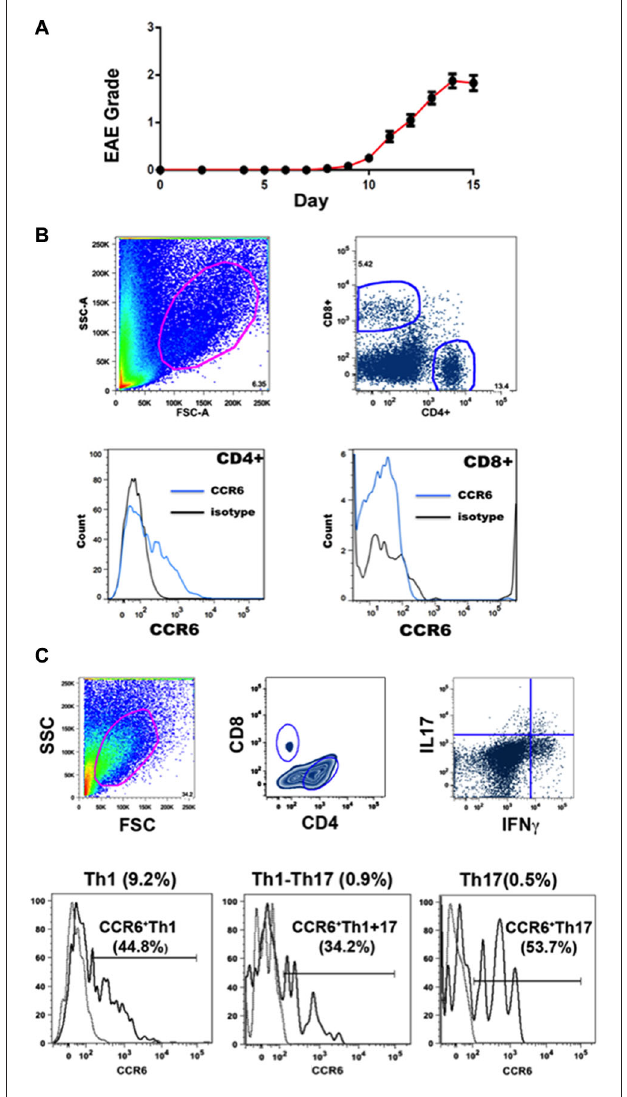
FIGURE 1 | EAE and flow cytometry. (A) Progression of EAE in mice immunized with MOGp35-55 (Mean clinical scores ± SEM, n = 184). (B) Gating strategies for flow cytometry analysis. CCR6 expression was detected in CD4 + T cells but not CD8 + T cells in CNS. Cells in the spinal cord were gated on the basis of size and granularity (top left), followed by CD4 and CD8 expression (top right) and CCR6 expression (CD4 + , lower left) and (CD8 + , lower right). Each sample was individually controlled for binding of isotype-matched antibody of irrelevant specificity. (C) Gating strategy for cell sorting. CCR6 expression was detected in both IL17 and IFN γ producing CD4 + T cells in spinal cord. Representative gating scheme depicting the morphological gate (top left), CD4 and CD8 gates (top middle), and IFN γ vs IL17 expression in CD4 + T cells. Subsequently, IFN γ , IL17 and IFN γ -IL17 dual producers were gated reative to isotype control for CCR6 expression (bottom histograms). Proportions of each subset within CNS CD4 + isolates are shown on top of each profile, and the percentages that expressed CCR6 are shown with the histograms.